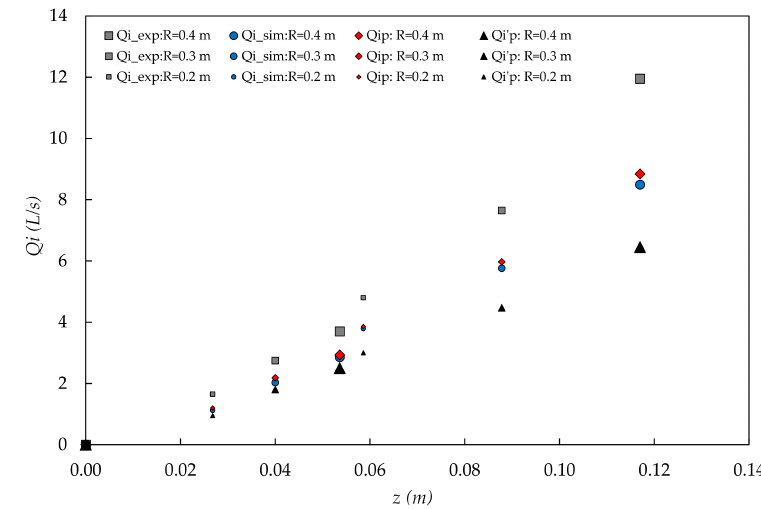
Figure 14. Flow rate for the initiation of the jet flow based on z and R . Qi p theoretical flow rate considering R ; Qi’ p theoretical flow rate not considering R ; Qi exp experimental flow rate; Qi sim numerical flow rate. Table 10. Comparison using the Absolute Error and the Relative Error of the numerical flow rate and theoretical flow rate for the initiation of the jet flow considering or not R .